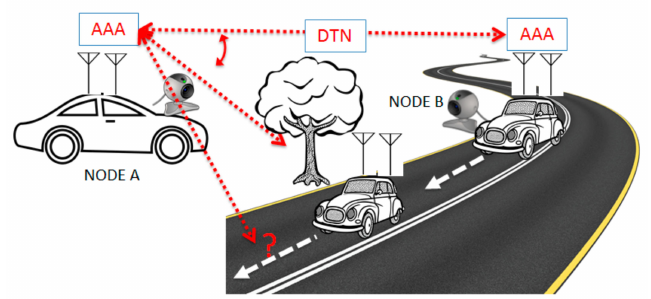
Figure 1. Proposed winter road surveillance